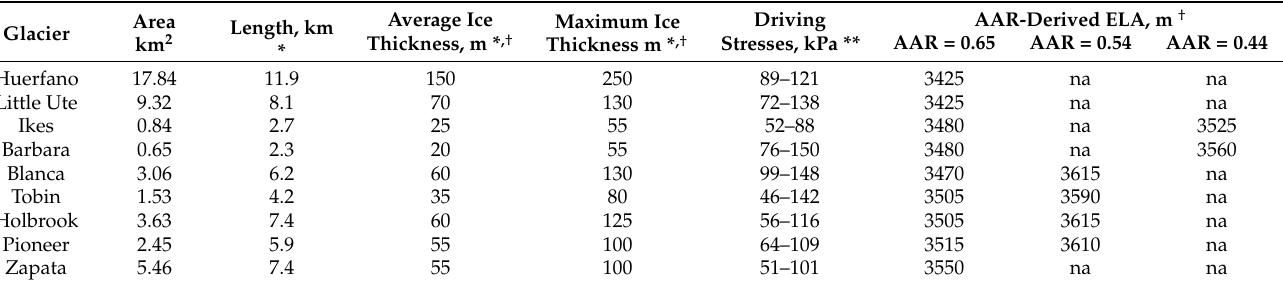
Surface area, length, mean, and maximum thickness, driving stresses, and AAR-derived ELAs of reconstructed glaciers. Glacier